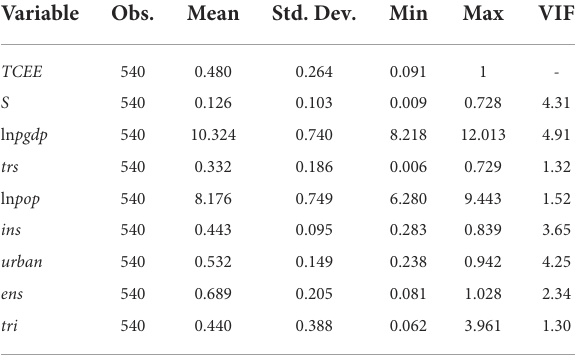
TABLE 3 Descriptive statistics and multicollinearity test of the variables. Variable